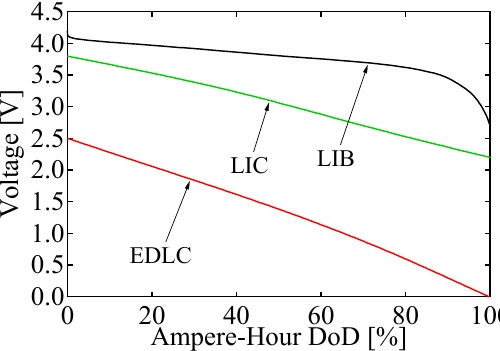
a function of ampere-hour DoD are shown in Figure 1. The typical voltage variation ranges of LIB cells are 2.7–4.2 V, whereas those of EDLCs and LICs are 0–2.5 V and 2.2–3.8 V, respectively. This suggests that DC–DC converters for EDCLs and LICs need to operate with a wide input/output voltage range. However, such wide input/output voltage operation generally impairs converters’ performance, such as power conversion efficiencies and volume.